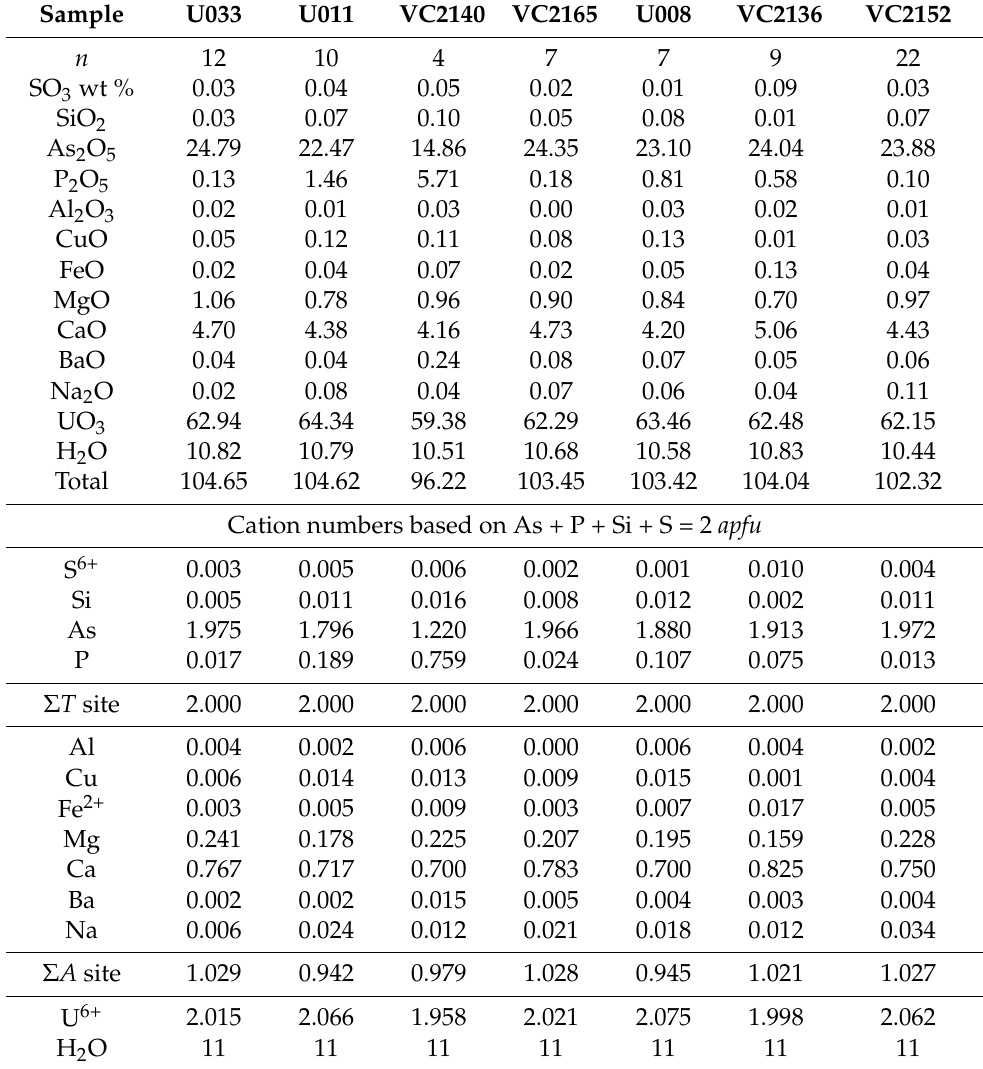
Table 6. Chemical composition of